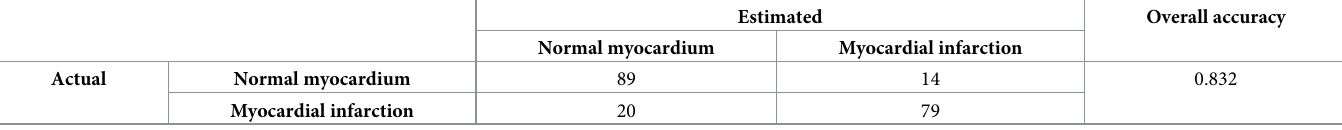
Table 4. Overall classification accuracy of the long short-term memory for the short-axis papillary muscle level images.